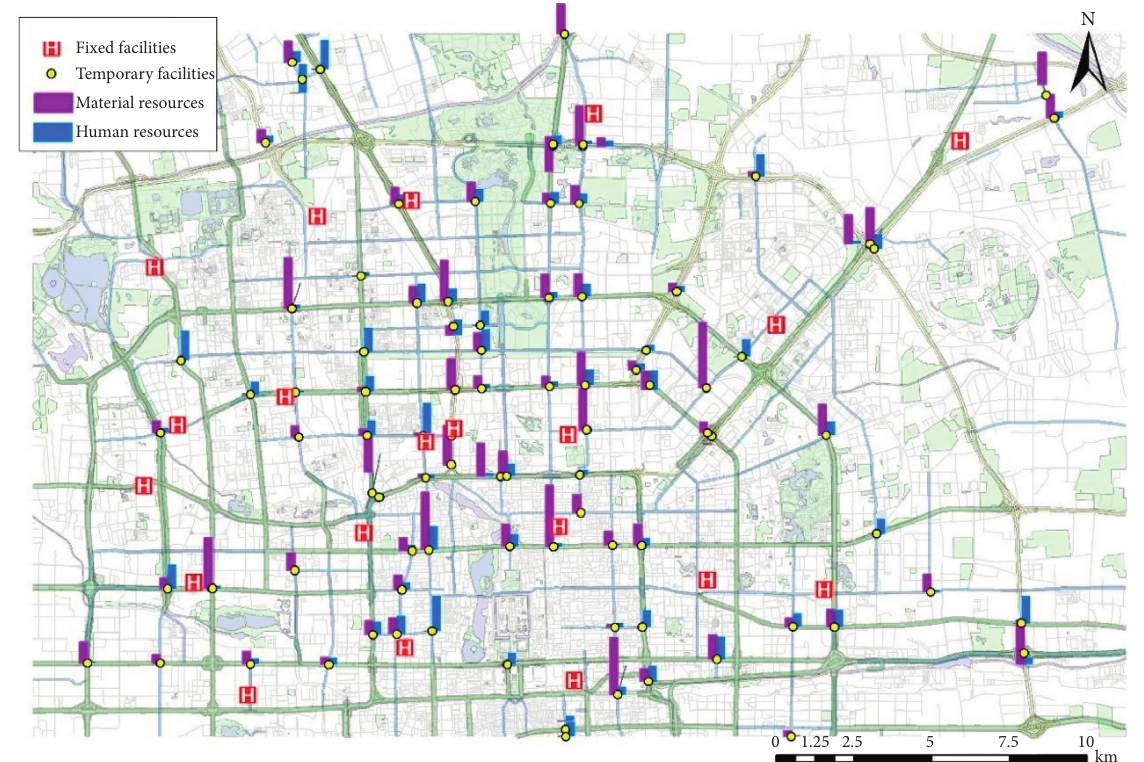
Figure 5: Visualization of